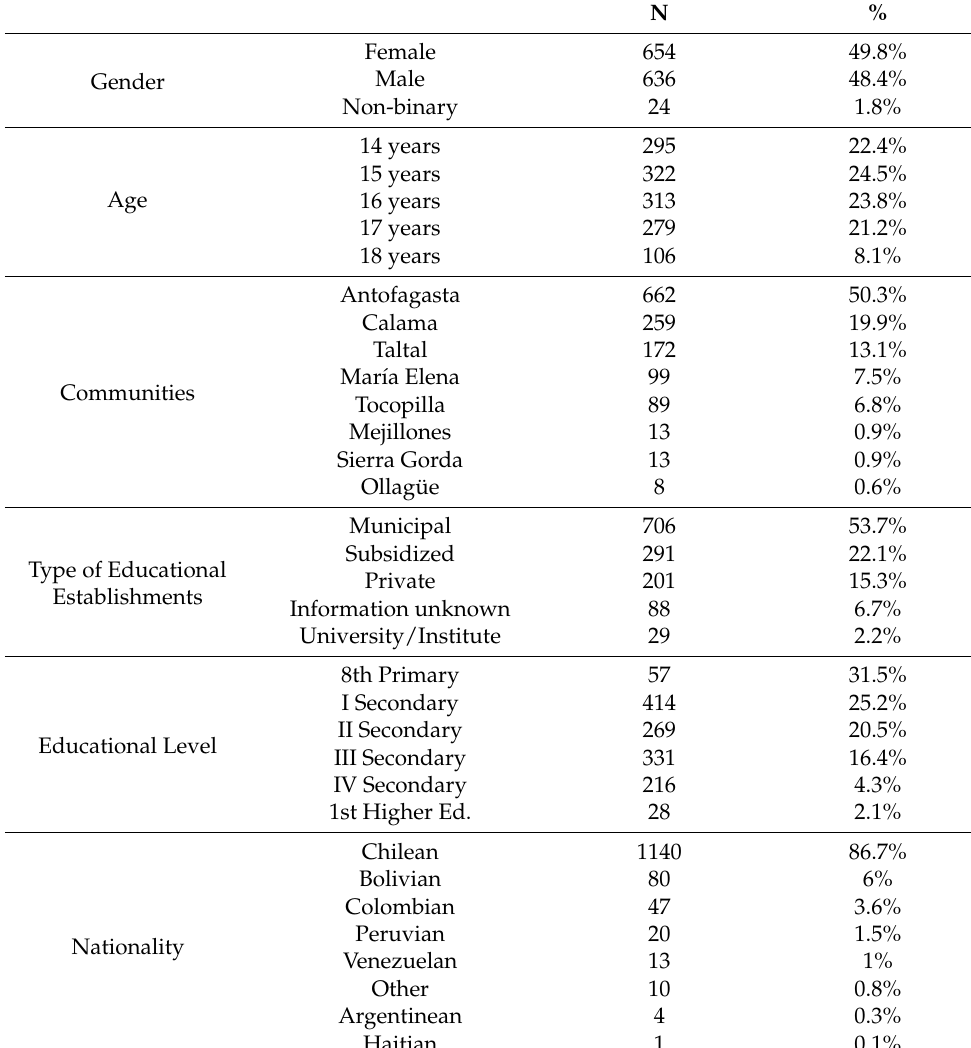
Table 1. Sociodemographic characteristics of the